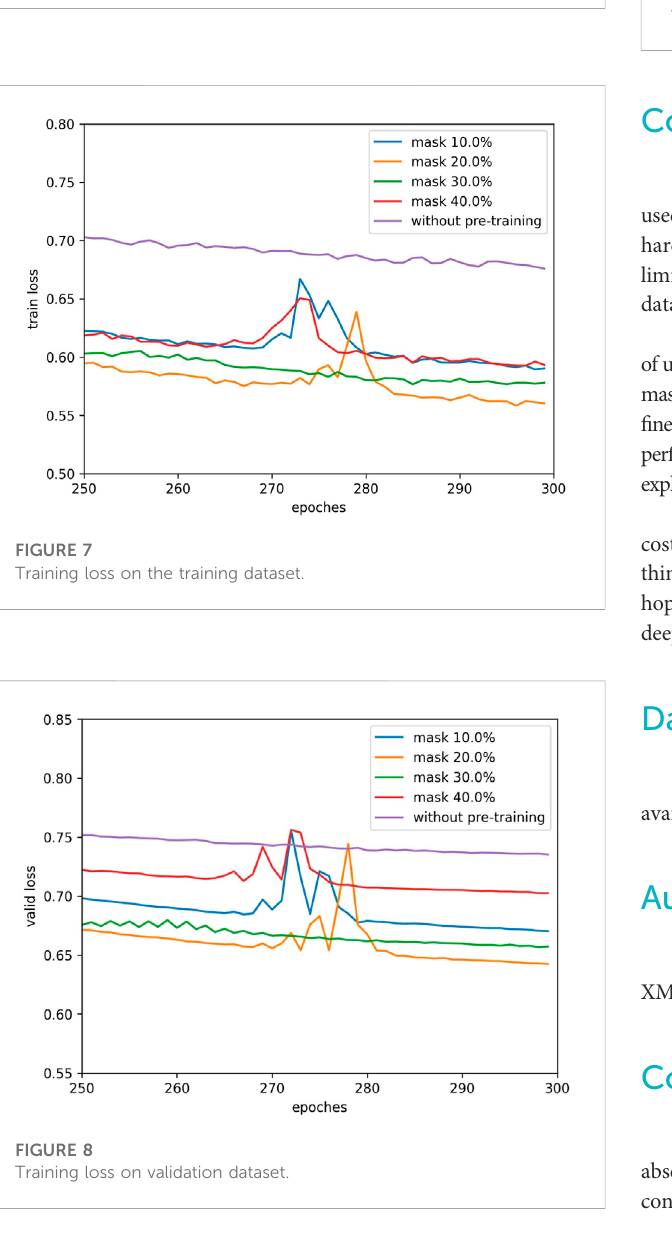
FIGURE 6 Schedule of learning rate of pre-training.